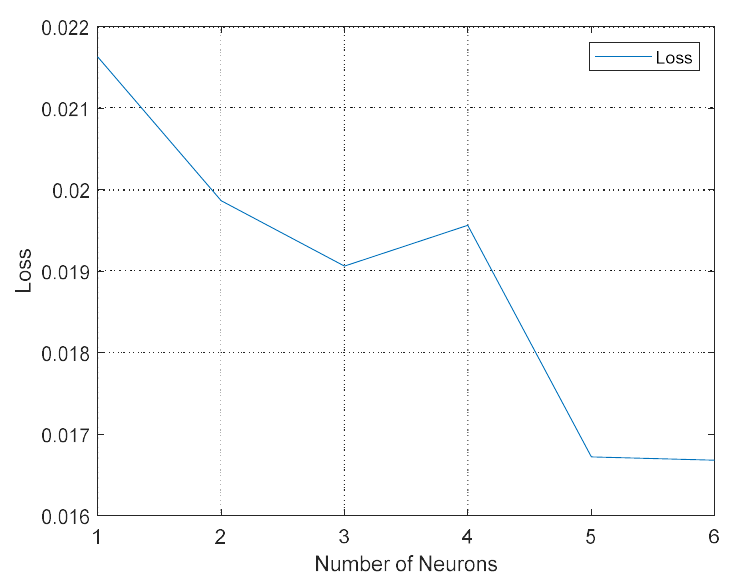
Figure 8. Loss rate with respect to the number of neurons